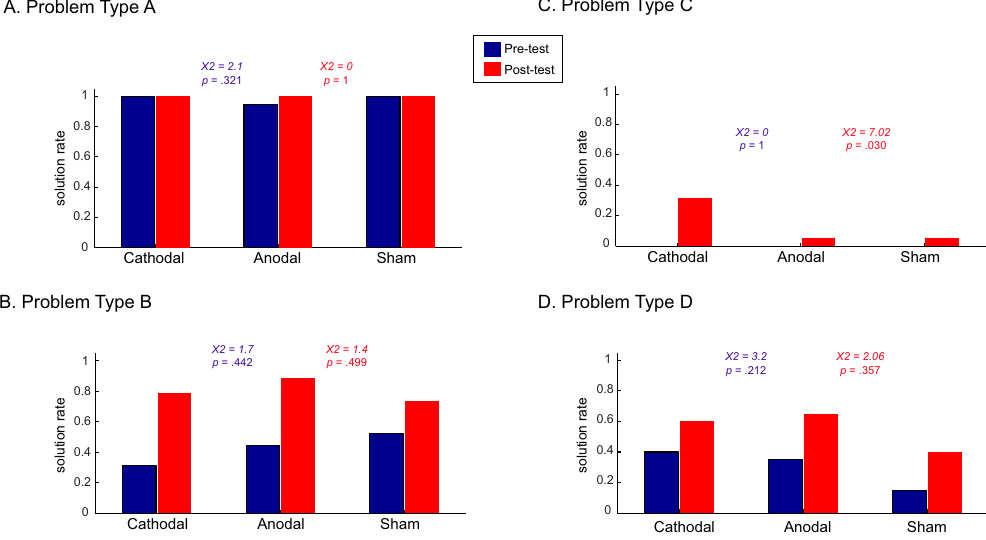
Figure 2. Solution rates (as the percentage of participants who solved the problem) before (blue) and after (red) cathodal, anodal and sham tDCS for problems type A, B, C, and D. Participants who solved problems type C in the pre-test were excluded from the analysis ( n = 4,/1 from cathodal, 2 from anodal and 1 from the sham group). Solution rate represents the proportion of participants within each stimulation group who managed to solve the problem correctly in the corresponding session (pre- and post-test). We tested the difference in the proportion of participants solving the problem between groups using chi-square. The numbers in blue are the results for the differences between groups in the pre-test and in red for the post-test. The proportion of participants who successfully solved the problems was significantly different between groups only for problems type C in the